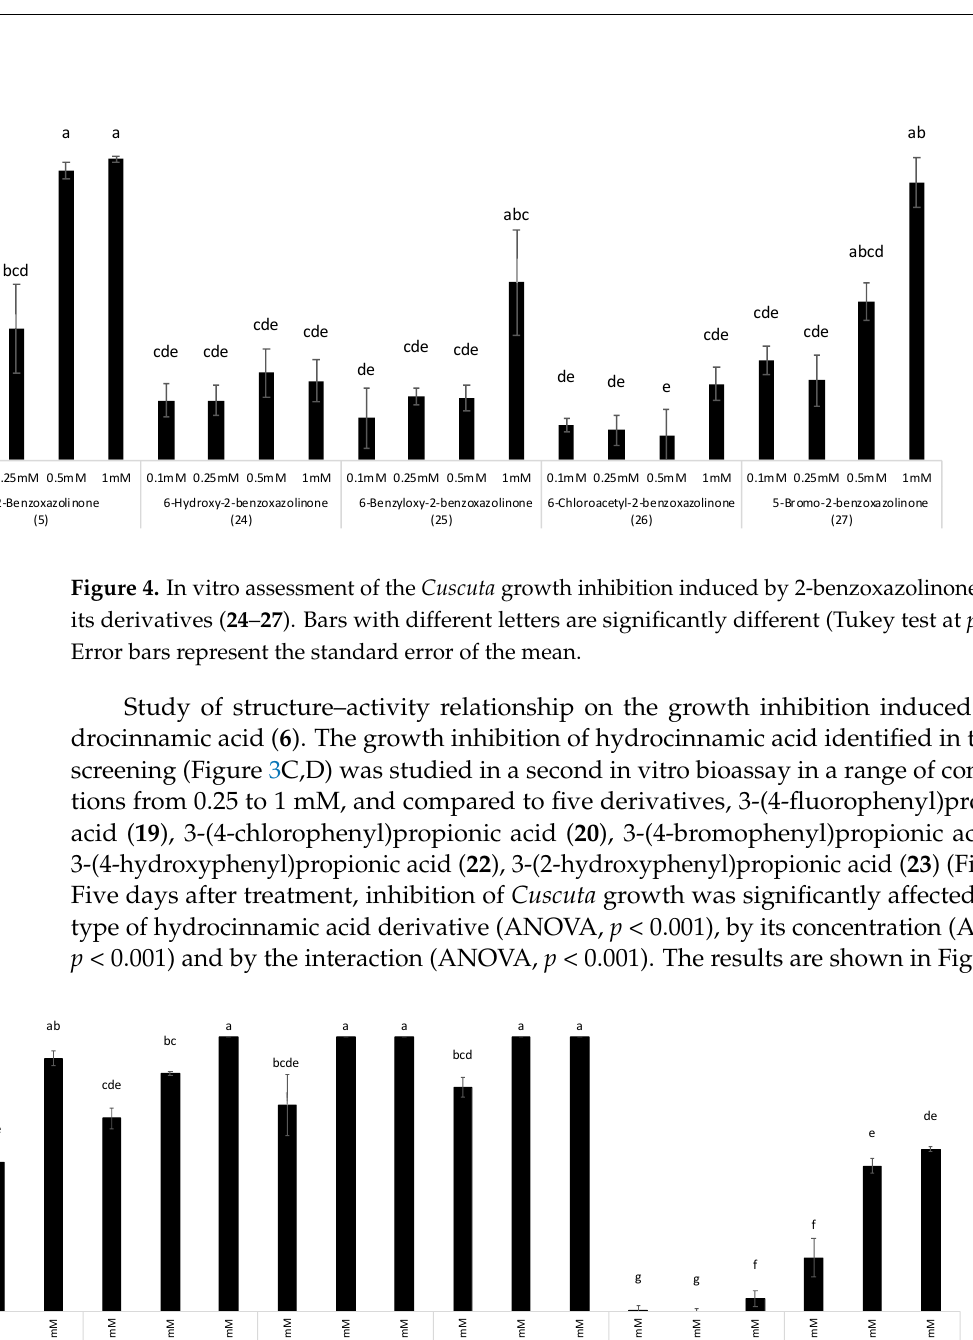
Figure 5. In vitro assessment of the Cuscuta growth inhibition induced by hydrocinnamic acid ( 5 ) and its derivatives ( 19 – 23 ). Bars with different letters are significantly different (Tukey test at p < 0.05).